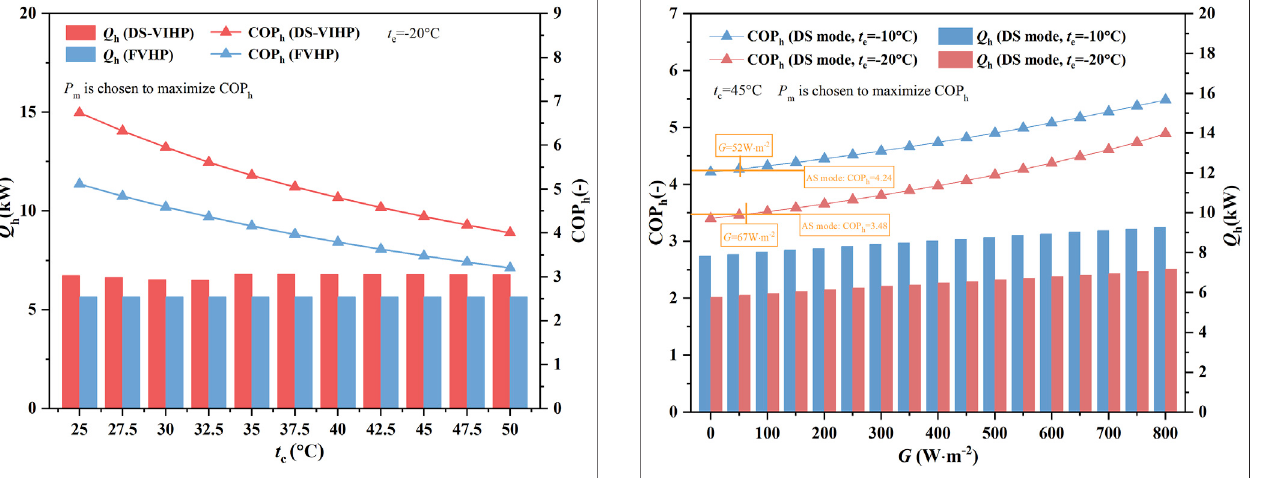
FIGURE 7 | Performance comparison under different solar